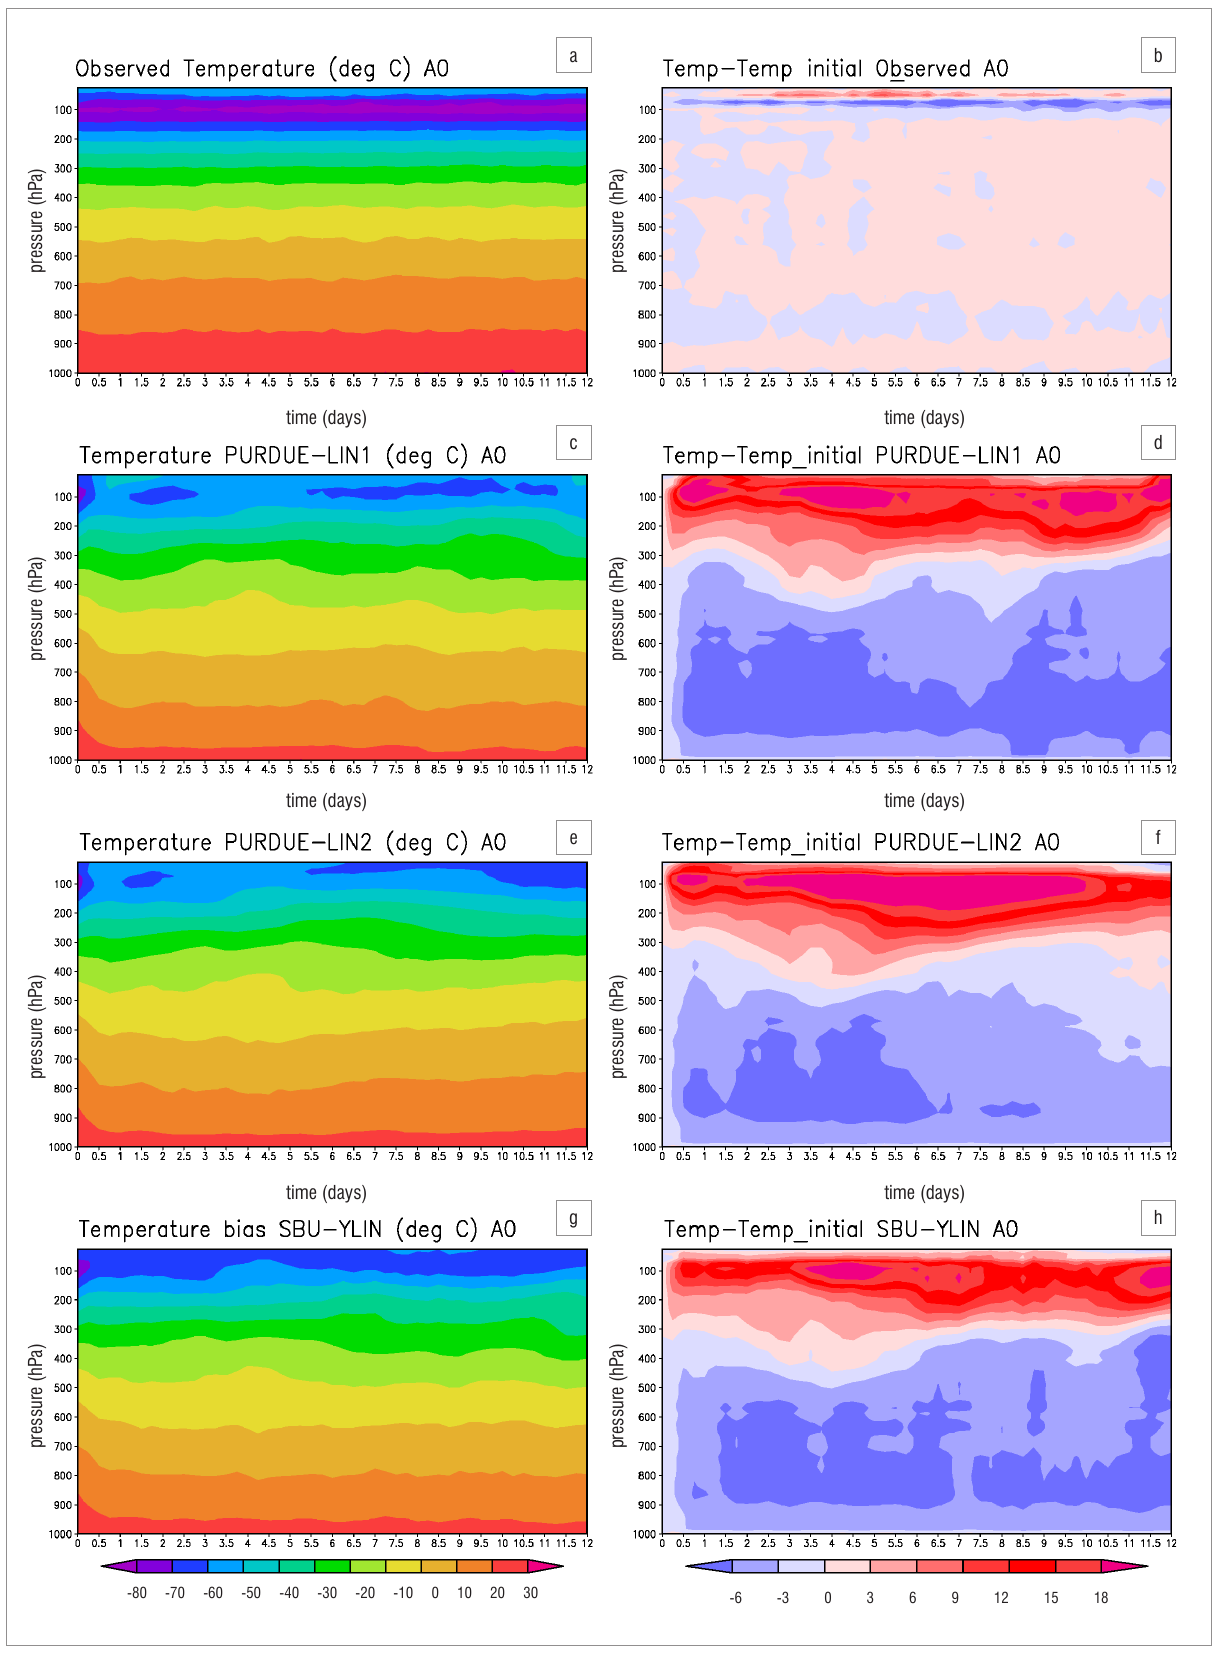
Figure 1: The temporal evolution of (a) observed temperature and (b) observed temperature relative to the initial conditions over a 12-day period with height expressed in pressure coordinates. (c,e,g) The temporal evolution of the simulated temperature by the different microphysics schemes and (d,f,h) temperature relative to the initial conditions for the A0